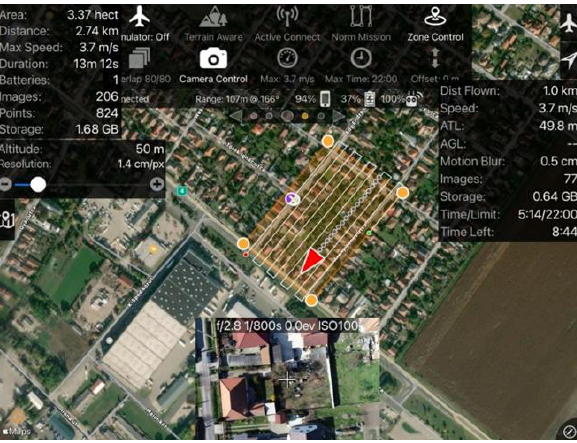
Figure 1 . Grid flight mission for one of the test areas.